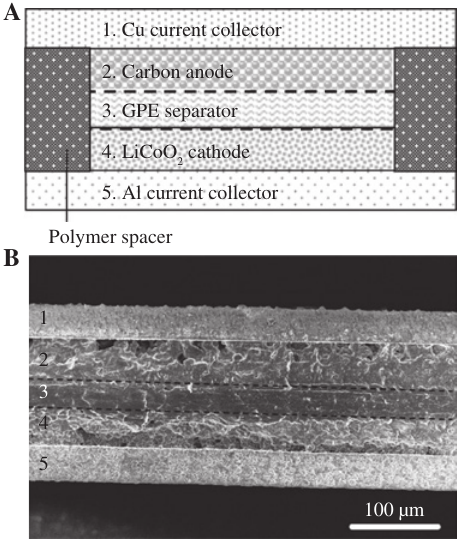
Figure 23: Cross-sectional view, (A) schematic, and (B) SEM micro- graph of a lithium-ion micro-battery fabricated by LIFT. Reprinted from